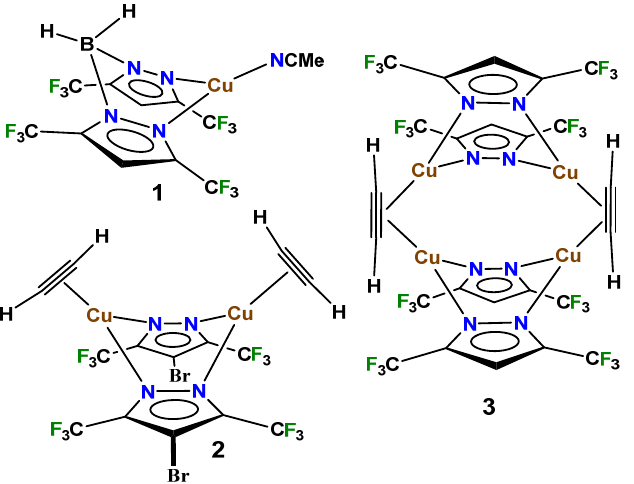
Figure 1. [H 2 B(3,5-(CF 3 ) 2 Pz) 2 ]Cu(NCMe) ( 1 ) and a selected group of structurally characterized cop- per complexes of acetylene, Cu 2 ( μ -[4-Br-3,5-(CF 3 ) 2 Pz]) 2 (HC ≡ CH) 2 ( 2 ) and Cu 4 ( μ -[3,5-(CF 3 ) 2 Pz]) 4 ( μ - HC ≡ CH) 2 ( 3 ).